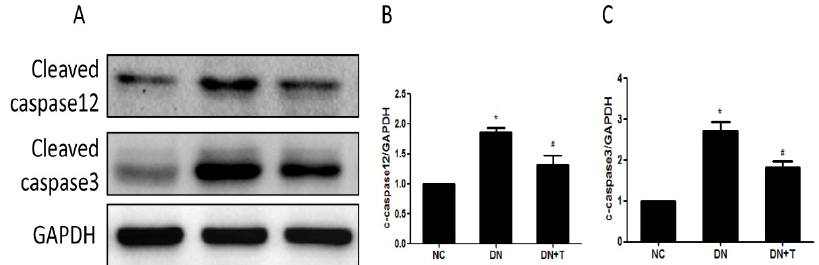
Figure 5. Effects of TUDCA on apoptosis in the kidney of diabetic mice. ( A ) Treating db/db mice with TUDCA for eight weeks could attenuate cleaved caspase12 and cleaved caspase3 protein expression as examined by Western blot. Each sample was normalized to GAPDH expression; Densitometric analysis of Western blots for cleaved caspase12 ( B ); and cleaved caspase3 ( C ) protein in extracts from renal cortex. Values are presented as means ± SEM ( n = 10). * p < 0.05 versus NC group. # p < 0.05 versus DN group.